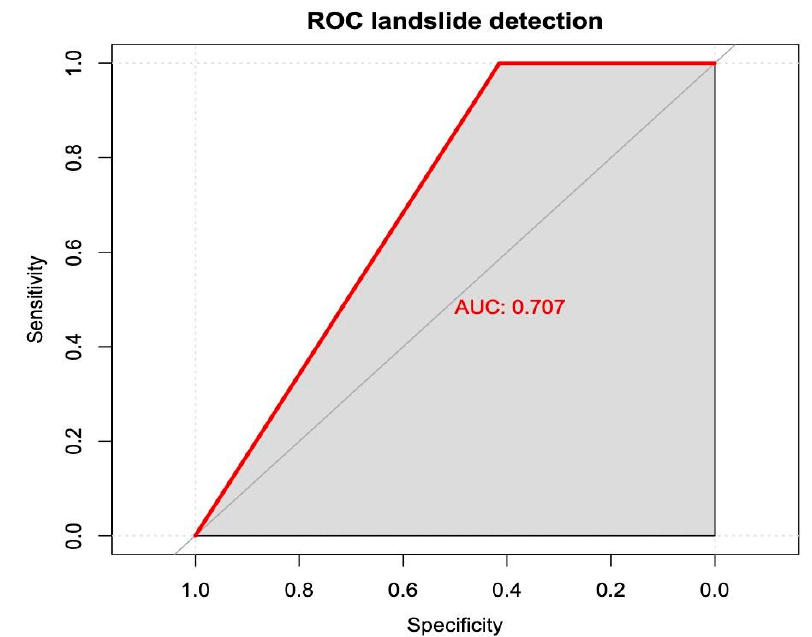
Figure 5. ROC curve and area under the curve (AUC) for the proposed landslide detection tool.